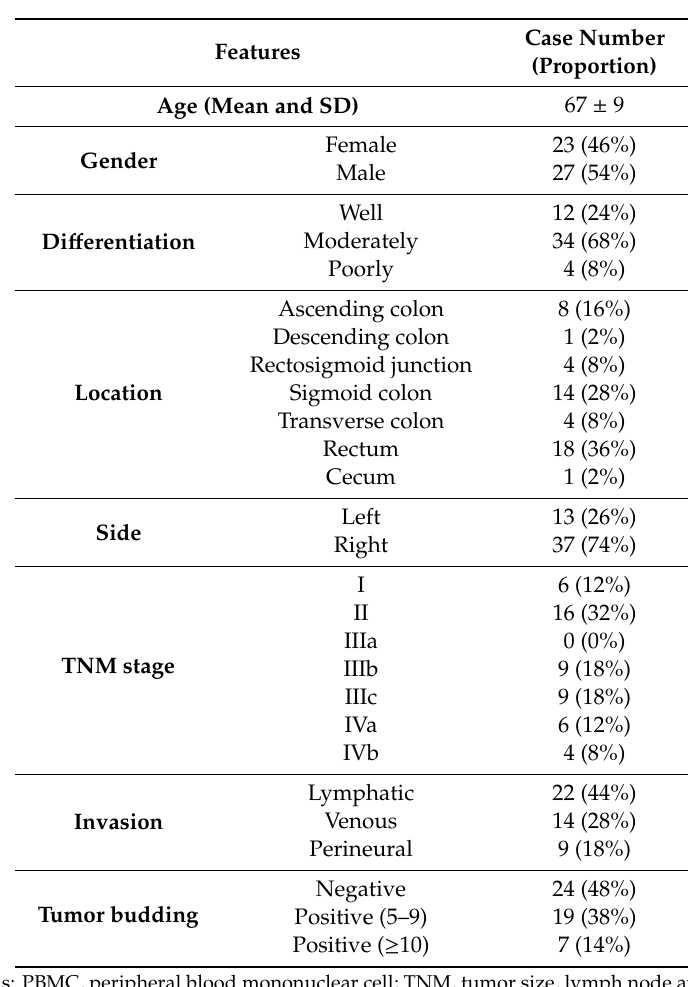
Table 1. Characteristics of colorectal cancer patients initially